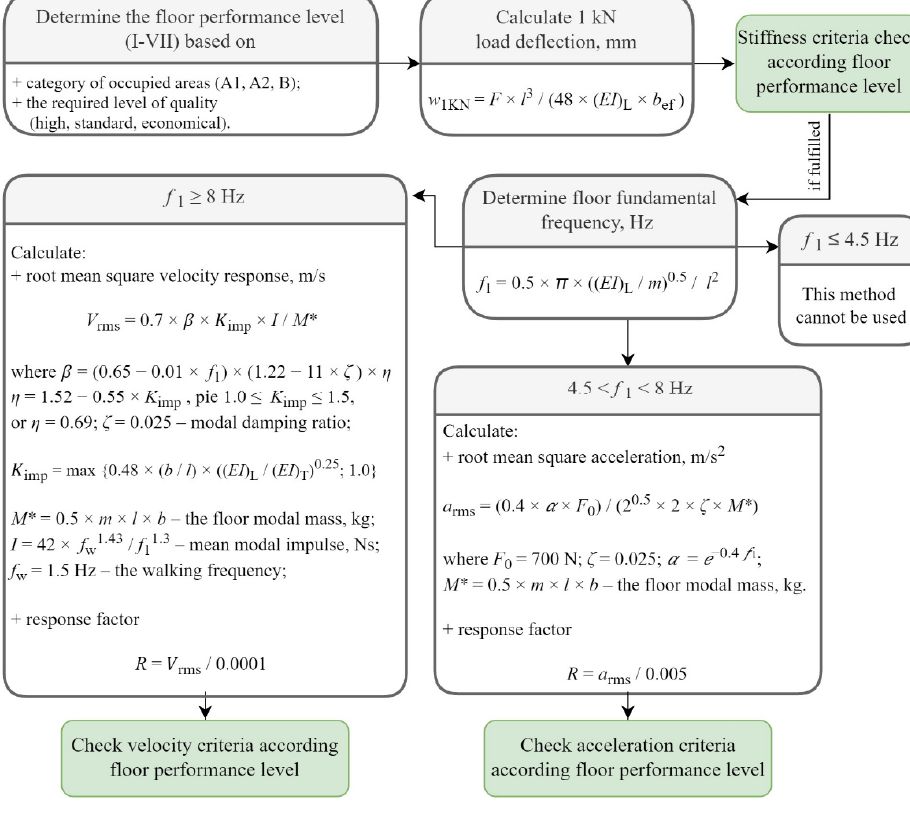
Figure 6. The algorithm of the vibration checks according to the forthcoming design rules “Vibrations. The limit values for all vibration criteria according to the floor performance level and the determination of the floor performance level according to the floor area use category and the required quality level are summarised in Tables 1 and 2,